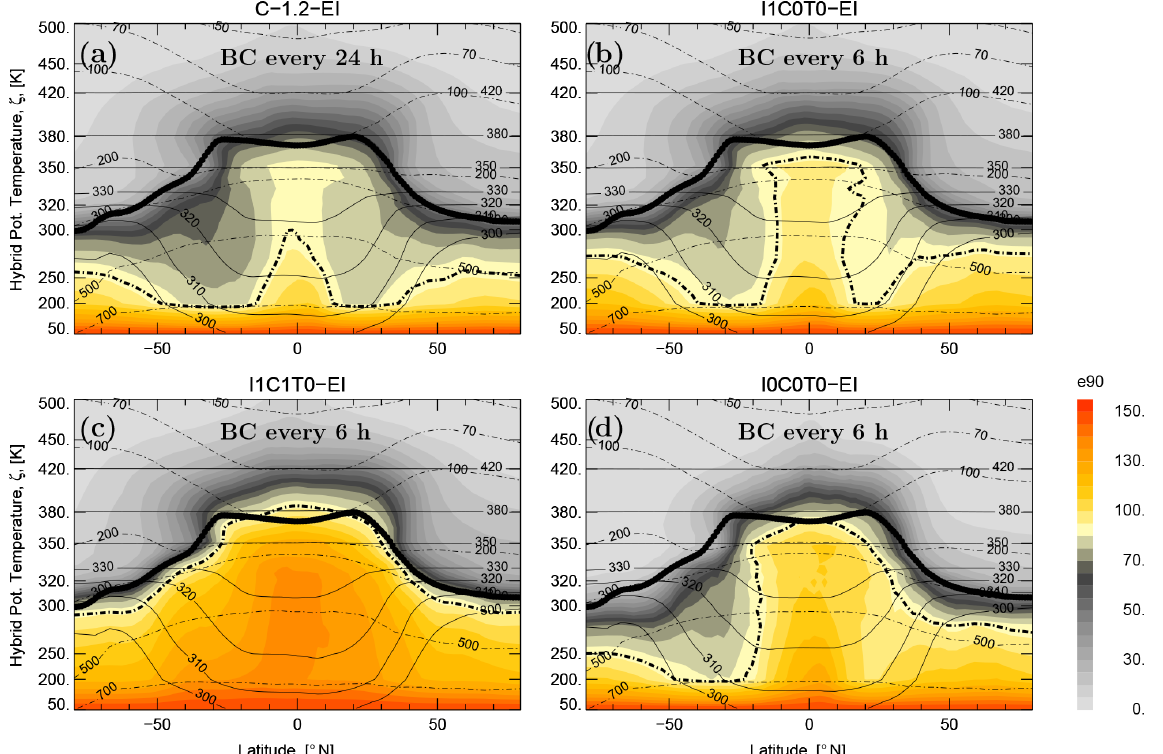
Figure 2. Zonal and monthly mean (December 2017) of the e90 tracer distribution for four CLaMS/EI configurations: with only isentropic mixing in CLaMS 1.2 (a) and 2.0 (b) , with isentropic mixing and unresolved convective updrafts in CLaMS 2.0 (c) and pure advection calculation in CLaMS-2.0 (d) . In CLaMS 1.2 the boundary condition (BC) is updated every 24h while in all CLaMS 2.0 configurations every 6h. The black dashed and solid lines are the 90ppbv isoline of the e90 tracer and the WMO tropopause, respectively.